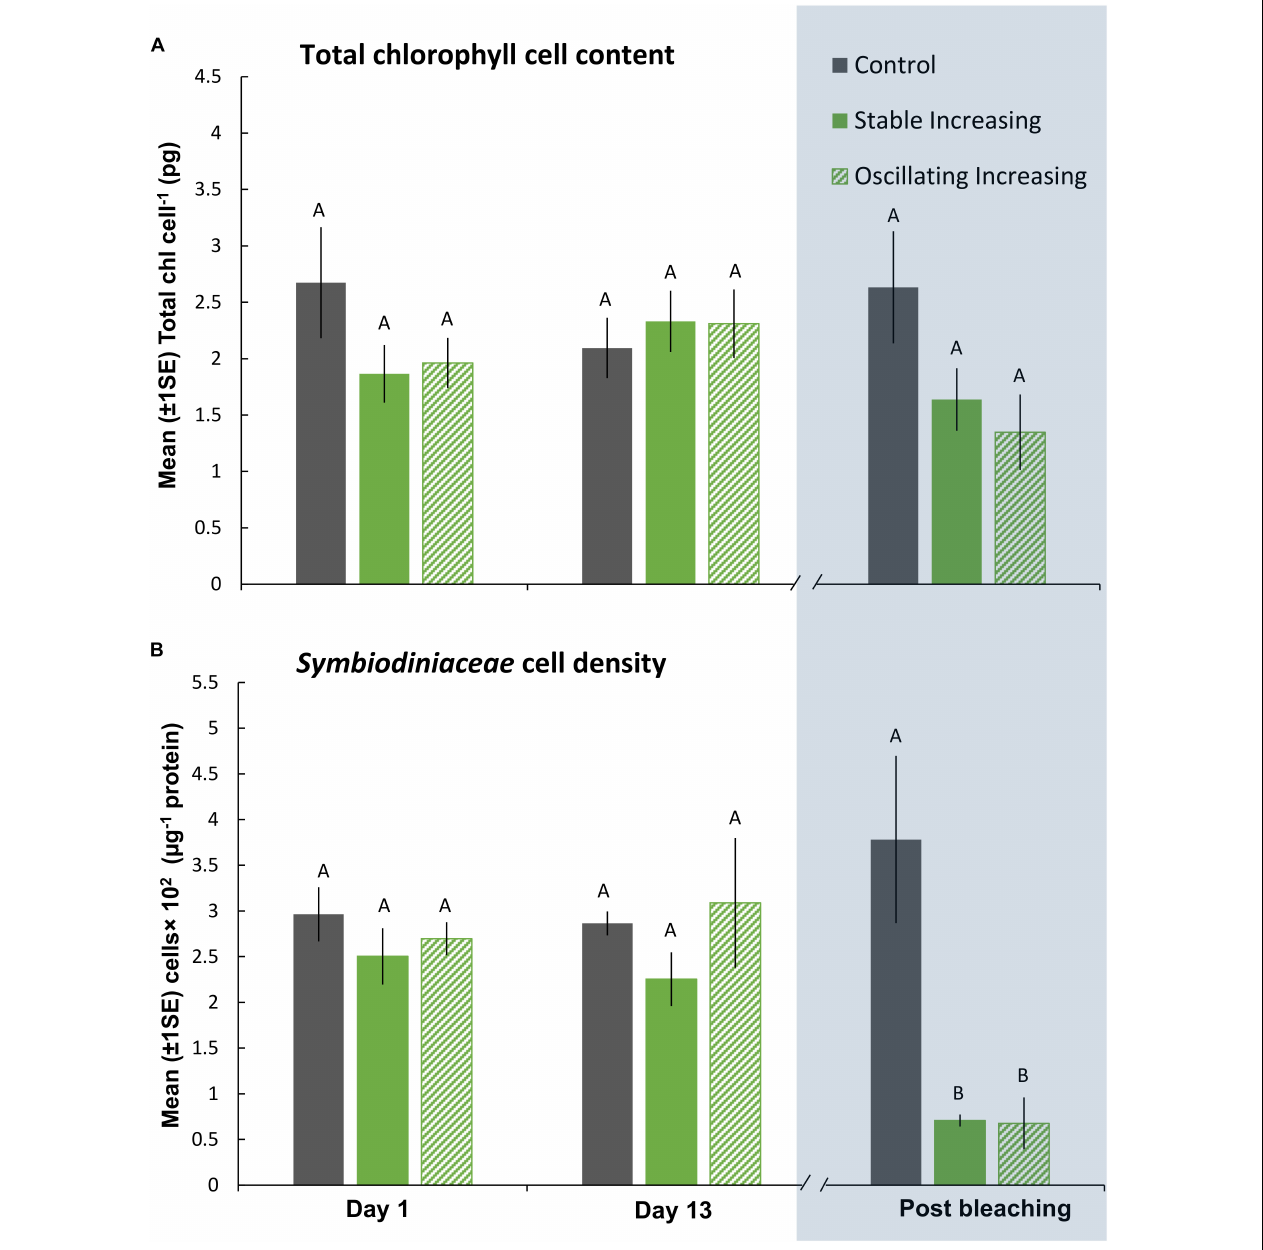
FIGURE 5 | Mean ( ± 1SE) rates of (A) total chl content (pg chl Symbiodiniaceae cell − 1 ) and (B) Symbiodiniaceae cell density ( µ g − 1 total protein) for each treatment (S Incr , O Incr , and Control) in the “Increasing” experiment (Part III) recorded at Day 1, 13, and post-bleaching. Letters next to data points indicate similarities (e.g., AA) or differences (e.g., AB) between the three treatments within each time point, as determined by estimated marginal means post hoc analyses, resulting from analyses reported in Supplementary Tables S8 , S9 . Note; sample sizes vary through time [Day 1 ( n = 5), Day 13 ( n = 3), Post-bleaching ( n = 3) ( n represents number of replicates per treatment)]. Days (and temperatures) at which medusae were sampled post-bleaching (shaded blue) differed, where medusae in the S Incr